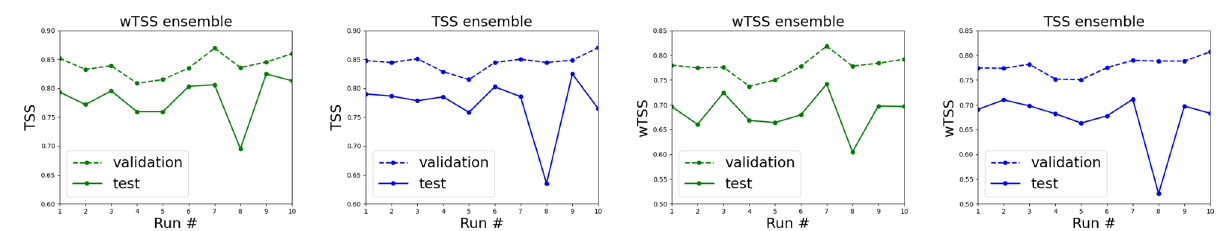
Figure 6. From right to left: TSS values on the validation set (dashed lines) and test set (continuous lines) obtained on each run by applying the wTSS-ensemble strategy (first panel) and the TSS-ensemble strategy (second panel); wTSS values on the validation set (dashed lines) and test set (continuous lines) obtained on each run by applying the wTSS-ensemble strategy (third panel) and the TSS-ensemble strategy (fourth panel).